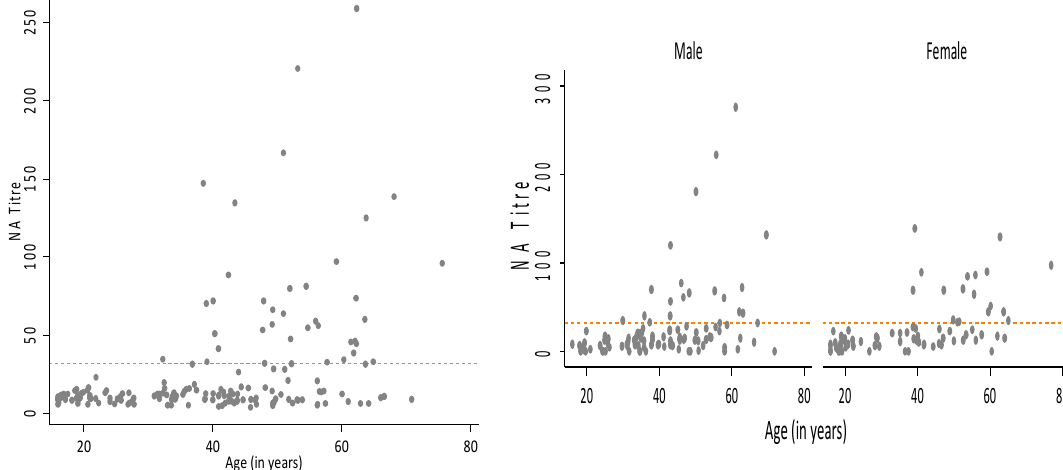
Figure 1. Plot of anti-vaccinia neutralising antibody titre by age, for total sample ( n = 177) and by sex ( n male = 100, n female = 77).